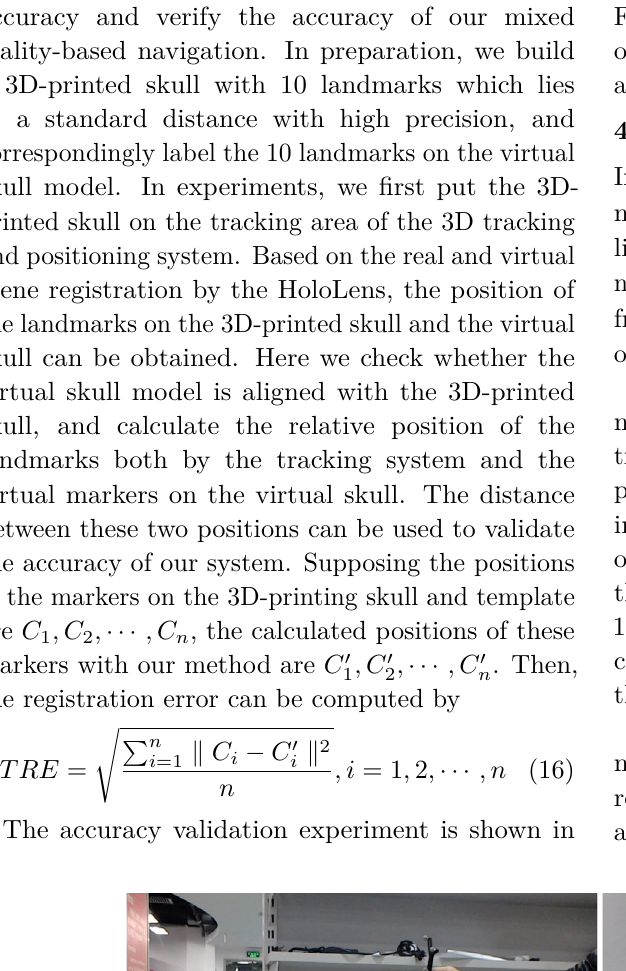
Fig. 6; the real position and the registration position of all feature points are as shown in Table 1. The average target registration error (TRE) is 2.24 mm.